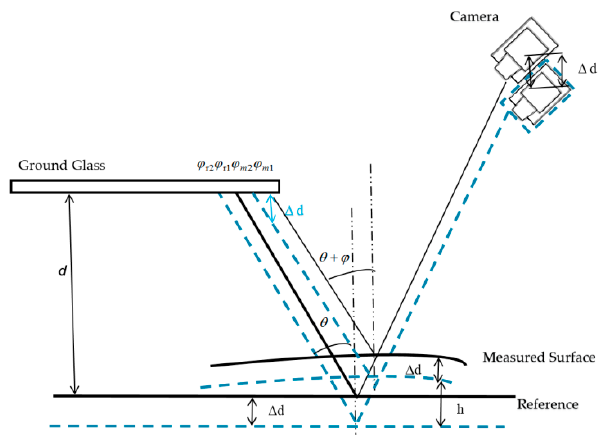
Figure 2. Schematic diagram of the IR-PMD method.